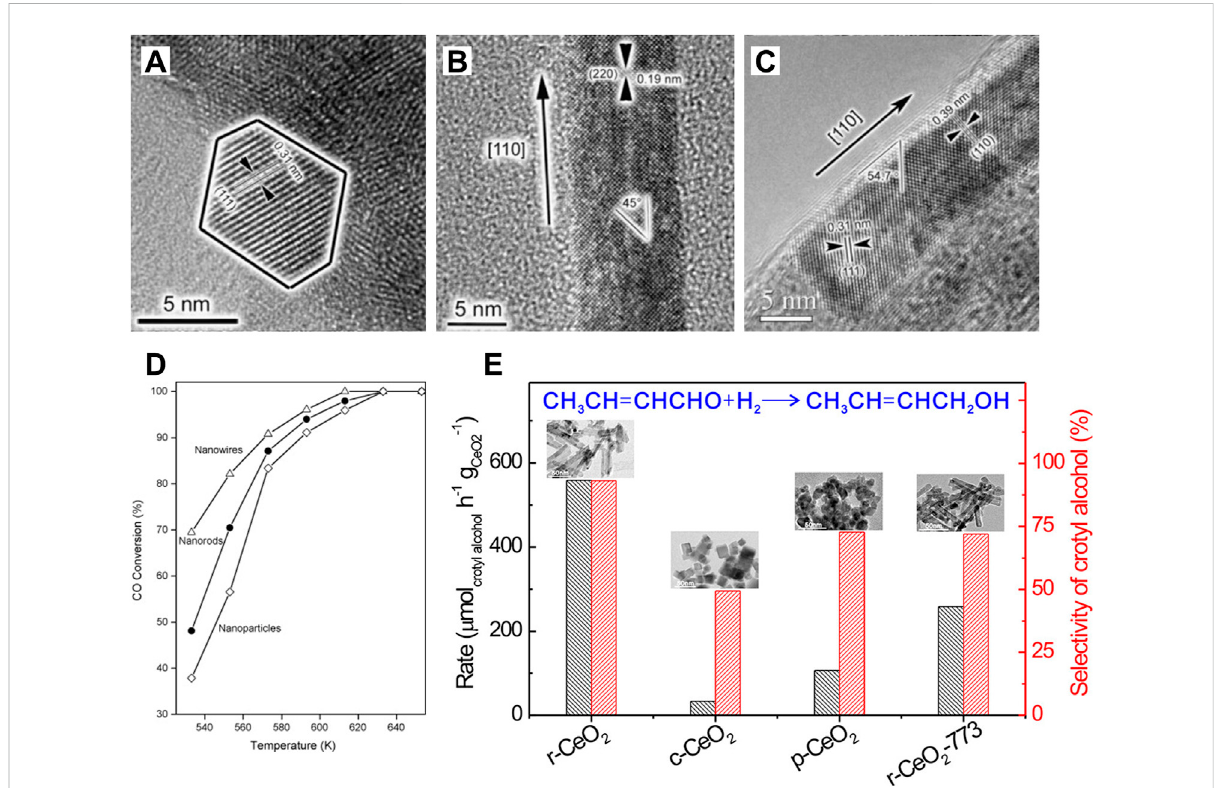
FIGURE 3 Crystal-plane-controlled catalytic performances: (A – C) Transmission electronic microscopy images of CeO 2 nanoparticles (A) , nanorods (B) and nanowires (C) ; (D) CO conversions over the CeO 2 nanostructures with different morphologies. Reproduced with permission (Tana et al., 2009). Copyright 2009, Elsevier. (E) Formation rate and catalytic selectivity of crotyl alcohol for the gas-phase selective hydrogenation of crotonaldehyde catalyzed by various CeO 2 at 323 K. Reproduced with permission (Zhang Z. et al., 2020). Copyright 2020, American Chemical